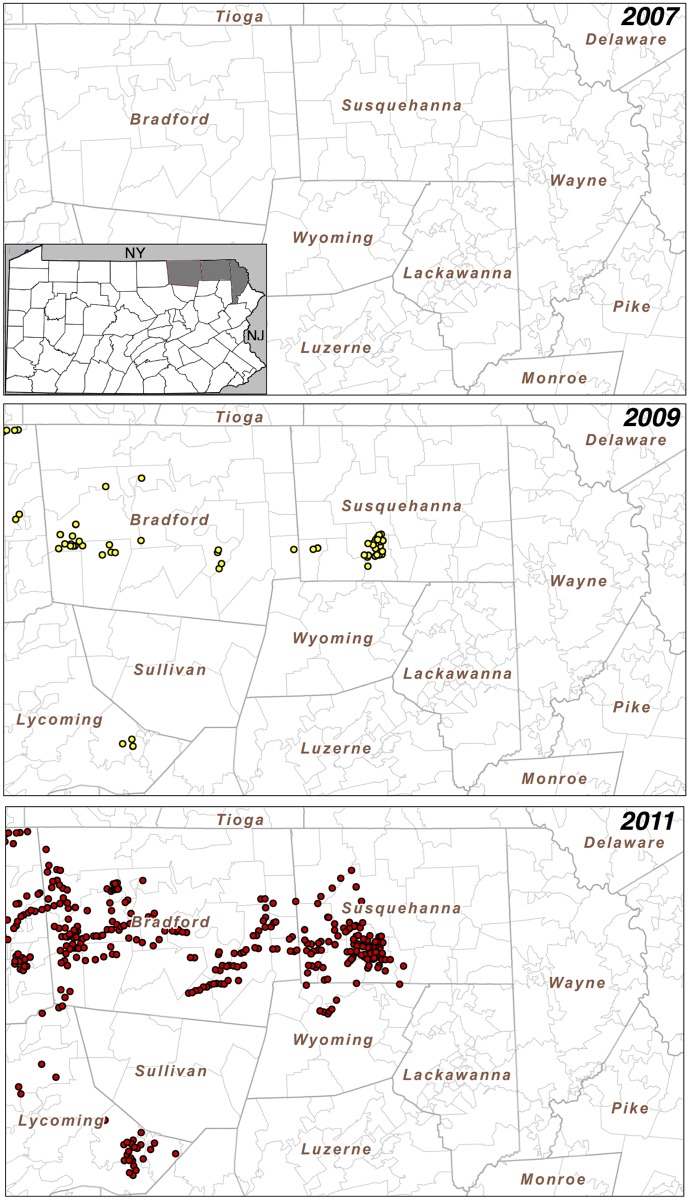
Pennsylvania active wells over time.Pennsylvania active wells in Bradford and Susquehanna Counties increased markedly from 2007 to 2011. Wells are shown as colored dots. From 2007 to 2011, Wayne County effectively had no active wells. Insert in the first panel shows location of Bradford, Susquehanna and Wayne Counties within Pennsylvania.